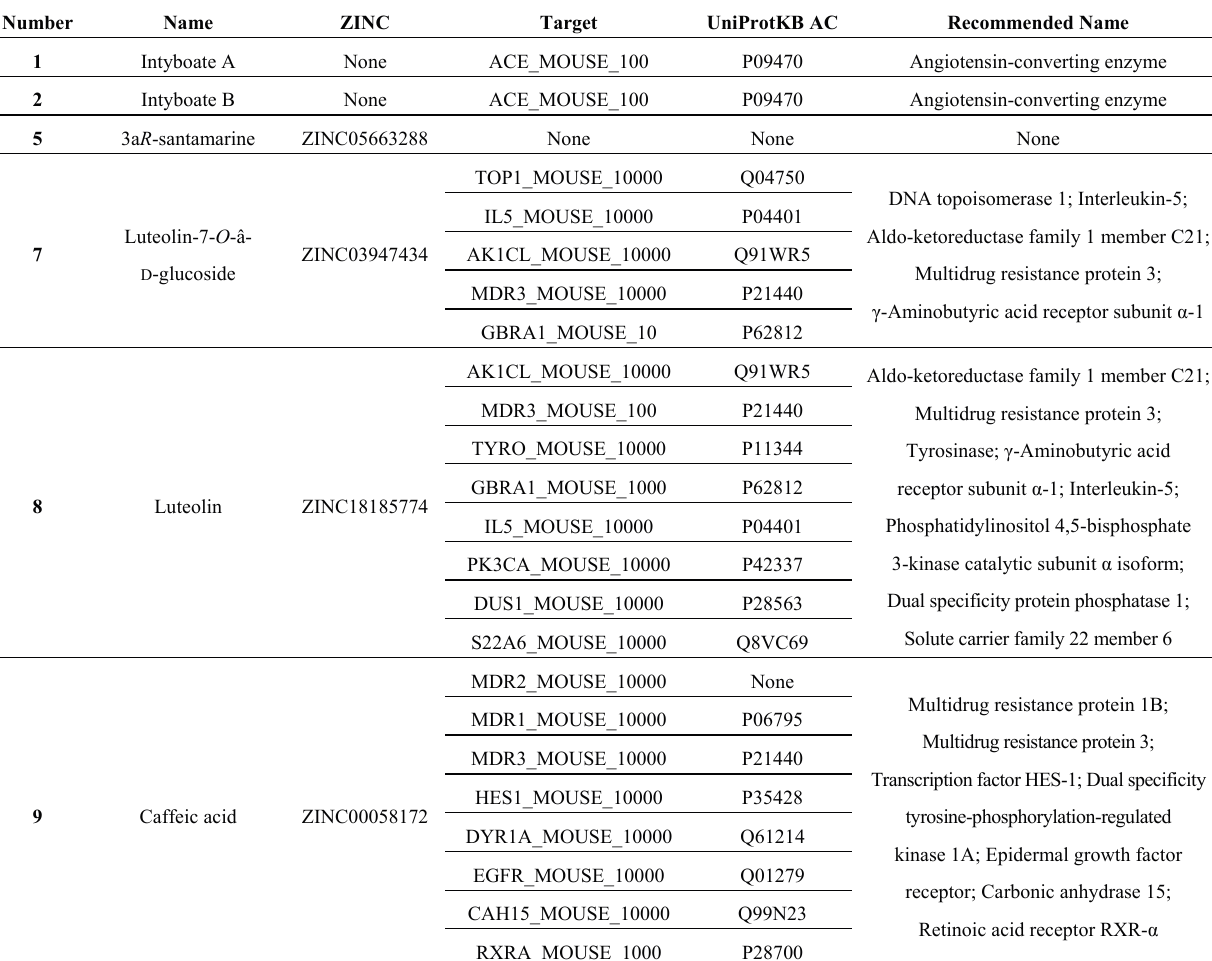
Table.2 Target proteins of small compounds in Cichorium intybus